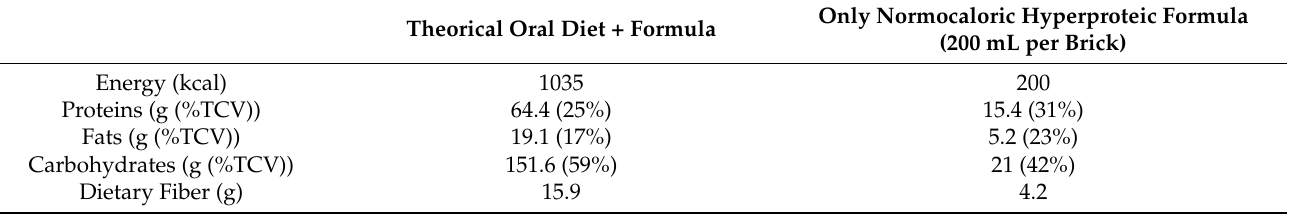
Table 1. Distribution of calories and macronutrients in the partial meal replacement diet, total diet plus formula (column 1), and only formula (column